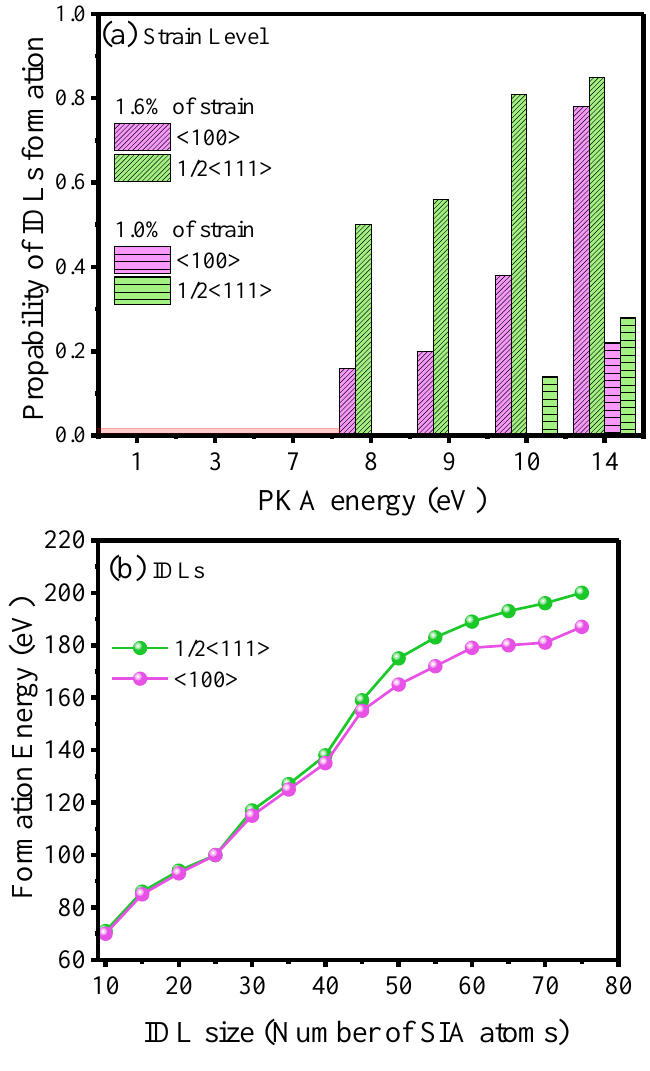
Figure 4. ( a ) The probability of IDLs formation for various strain levels and PKA energies. The probability is the number of IDLs that occurred across the 16 different simulation sets. There were two types of dislocations formed, which were either ½ <111> or <100>. The graphs depict the impacts of two strain values of 1.6% and 1.0%, respectively. ( b ) IDL formation energy for different number of SIAs. The results of 1/2<111> and <100> IDL are shown with green and pink, respectively. It is also worth noting that the number and type of IDLs vary depending on vibration timing and collision displacement direction, as shown in Figure 5. The dislocation lines show that no embedded atoms interfere with the FP ’ s point defects, and the defects formed are classified as monovacancy, mono SIA, cluster (two or more SIAs or vacancies), and dislocation loops. However, as PKA levels rise, the length of the dislocation loop appears to be extended (see Supplementary Materials Videos S1 and S2). Even if the kinetics differ from ab initio calculations [44] due to the absence of subcascades in tungsten, as opposed to iron [34], then the conclusion that local strain application leads to IDLs formation at lower PKA energies will not be affected by the different kinetics.